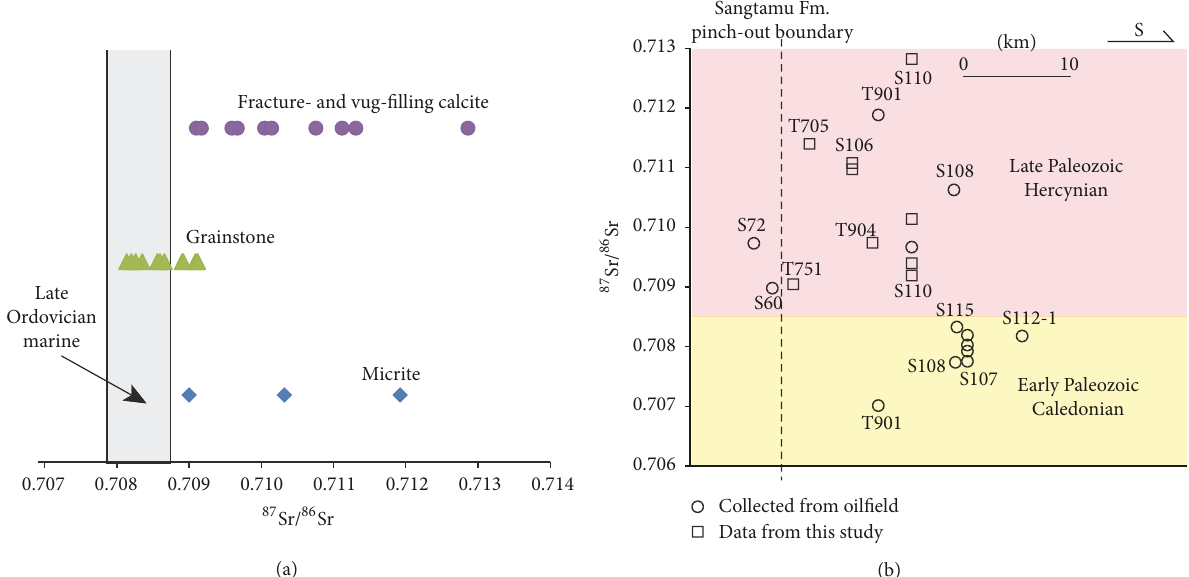
Figure 9: Characteristics of 87 Sr/ 86 Sr values from the Lianglitag Formation. (a) 87 Sr/ 86 Sr values of micrite, grainstone, and fractures and vug-filling calcite. (b) Distribution of 87 Sr/ 86 Sr values from different wells in plane.